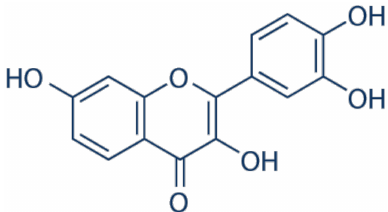
Figure 7. The chemical structure of